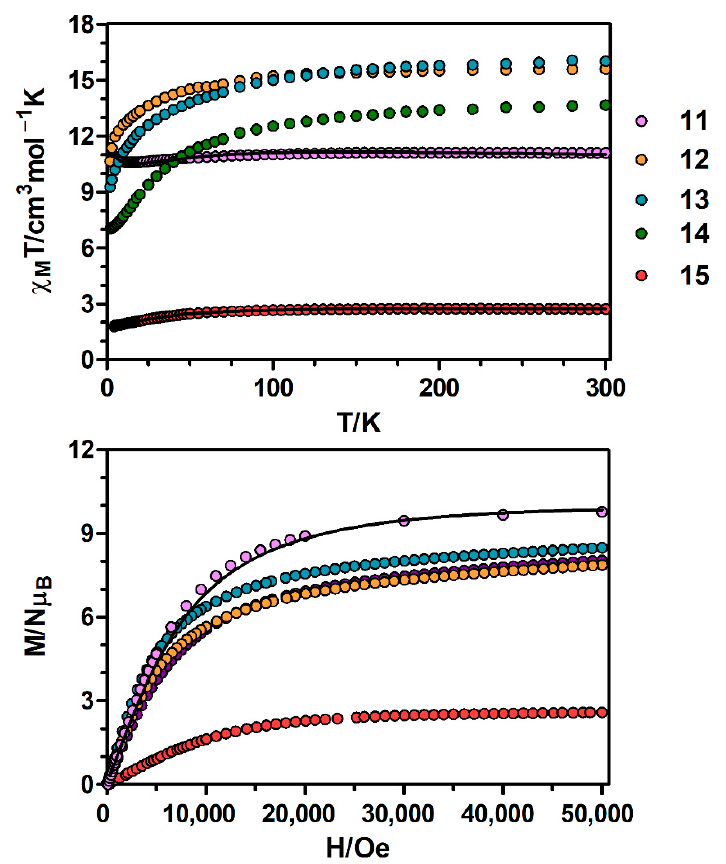
Figure 5. Top: Temperature dependence of the χ M T product at 1000 Oe for complexes 11–15 . Bottom: M versus H plots for complexes 11–15 at 2 K. Black solid lines show the best fits for complexes 11 and 15 .